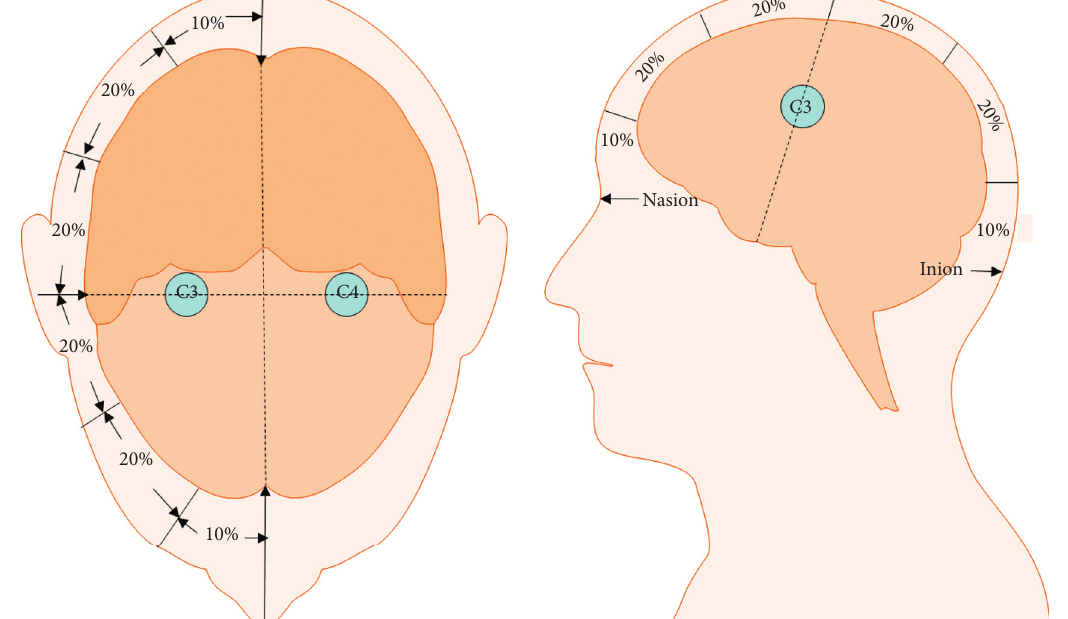
Figure 1: EEG electrode distribution in accordance with the 10–20 EEG system. The electrodes used for acquisition are